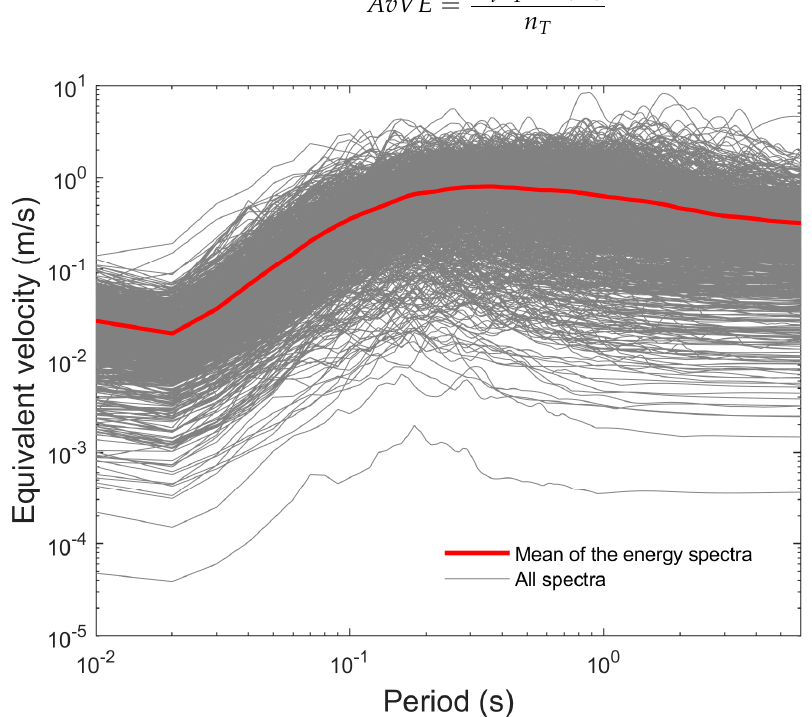
Figure 5. Equivalent velocity spectra or input energy spectra for the selected and scaled ground motion records.